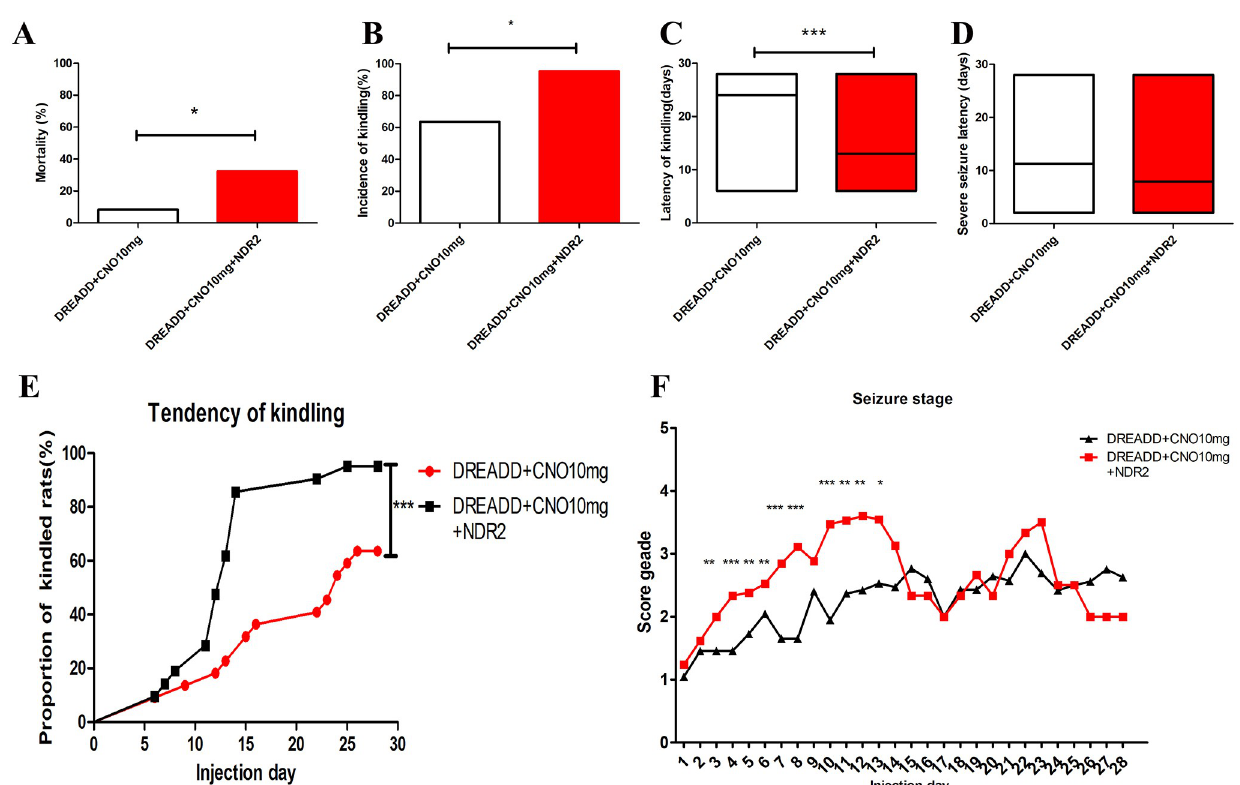
Fig 7. NDR2 overexpression in hippocampus suppressesed the effect of CNO administration on epileptogenesis in PTZ kindling rat model infected with hM4Di vector in DG. Mortality(A), kindling rate(B), latency of kindling(C), severe seizure latency(D), tendency of kindling(E) and seizure stage(F) between DREADD+CNO group and DREADD+CNO+NDR2 group. CNO, clozapine N-oxide; DG, dentate gyrus. * indicates P < 0.05, ** indicates P < 0.01, *** indicates P <